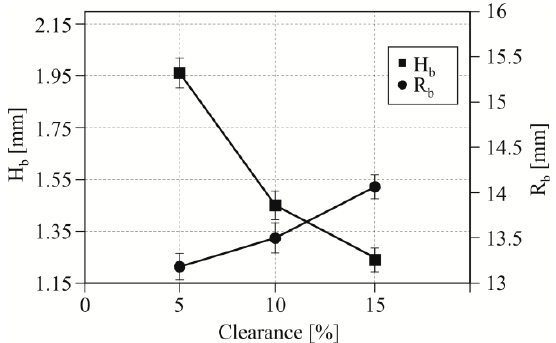
Figure 9. The influence of the blanking clearance ( C ) on the radius R b and the hook H b deviation after the first punching strokes.